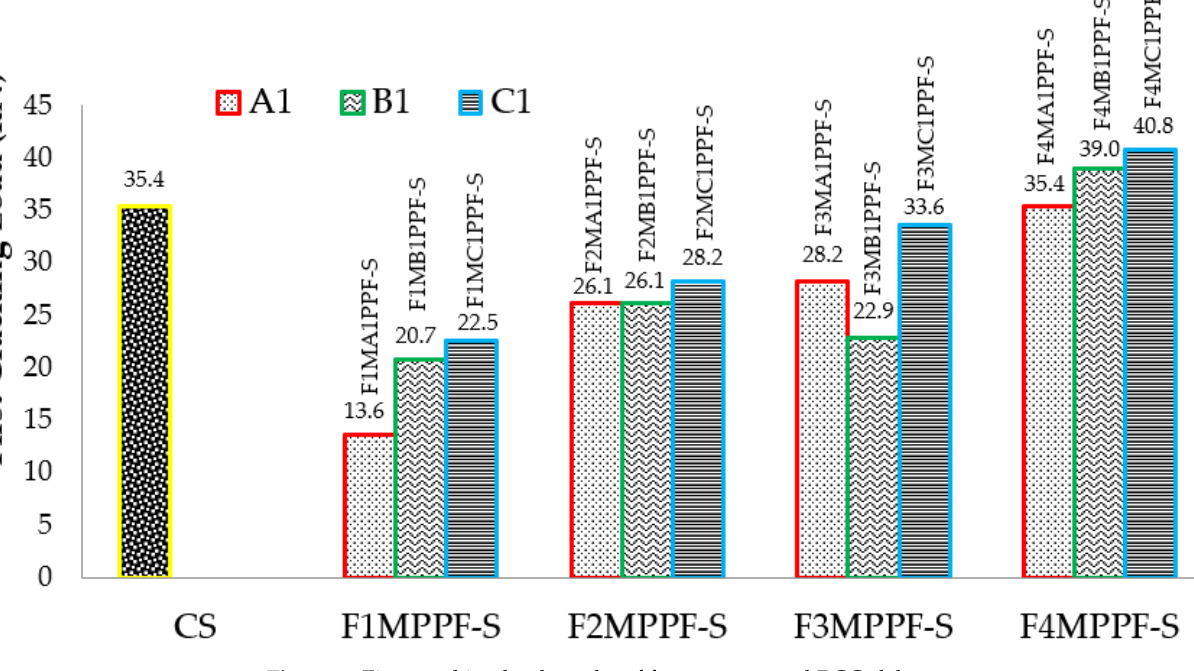
Figure 9. First cracking load results of ferrocement and RCC slab.